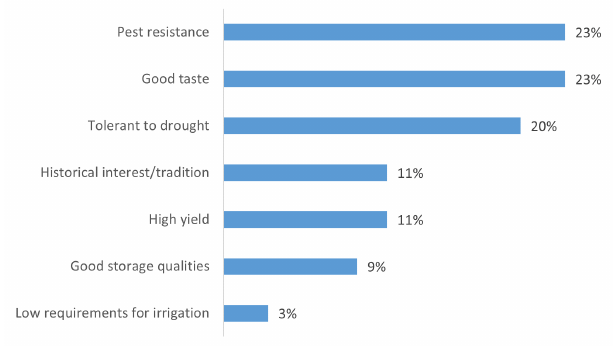
Figure 5. The importance given by the survey participants to different landrace conservation measures (based on the responses of the 75 interviewees and participants in the 25